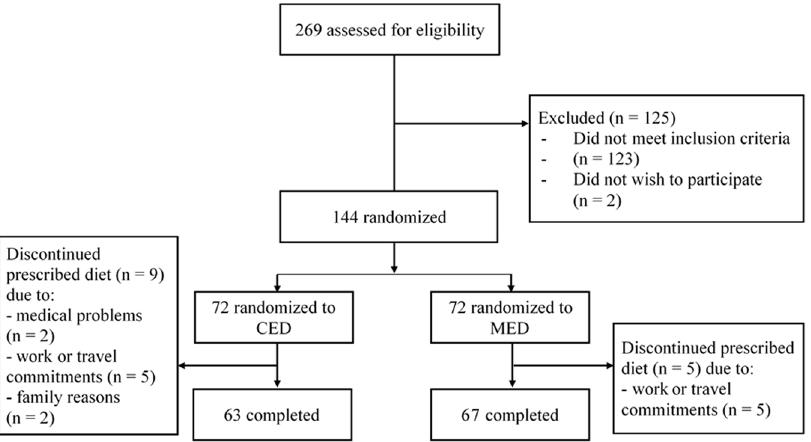
Figure 1. Flow diagram of subjects’ participation in the trial.